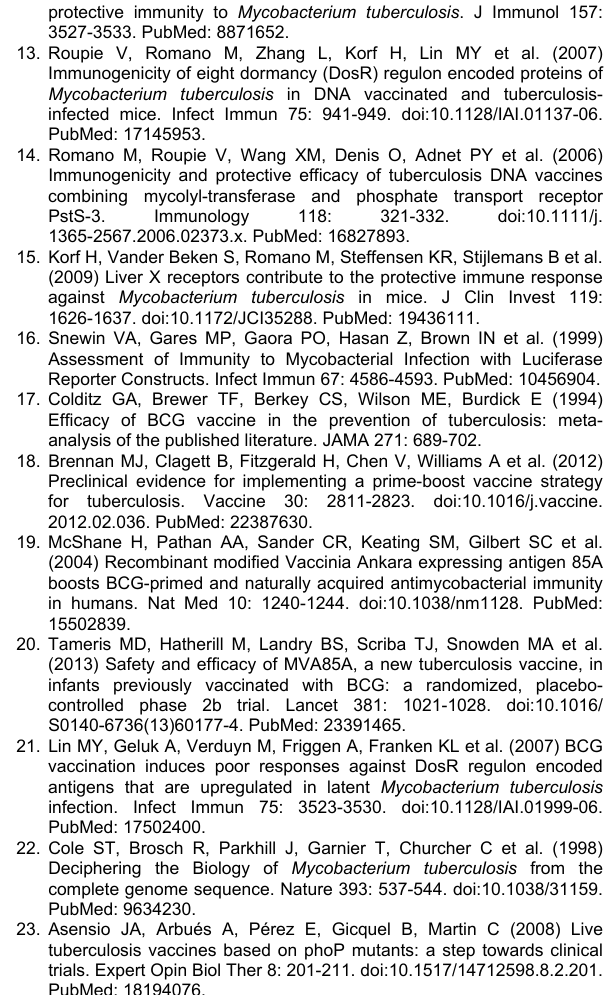
strain. Median survival time was 7 weeks for mice infected with WT M.tb strain versus 29 weeks for mice infected with